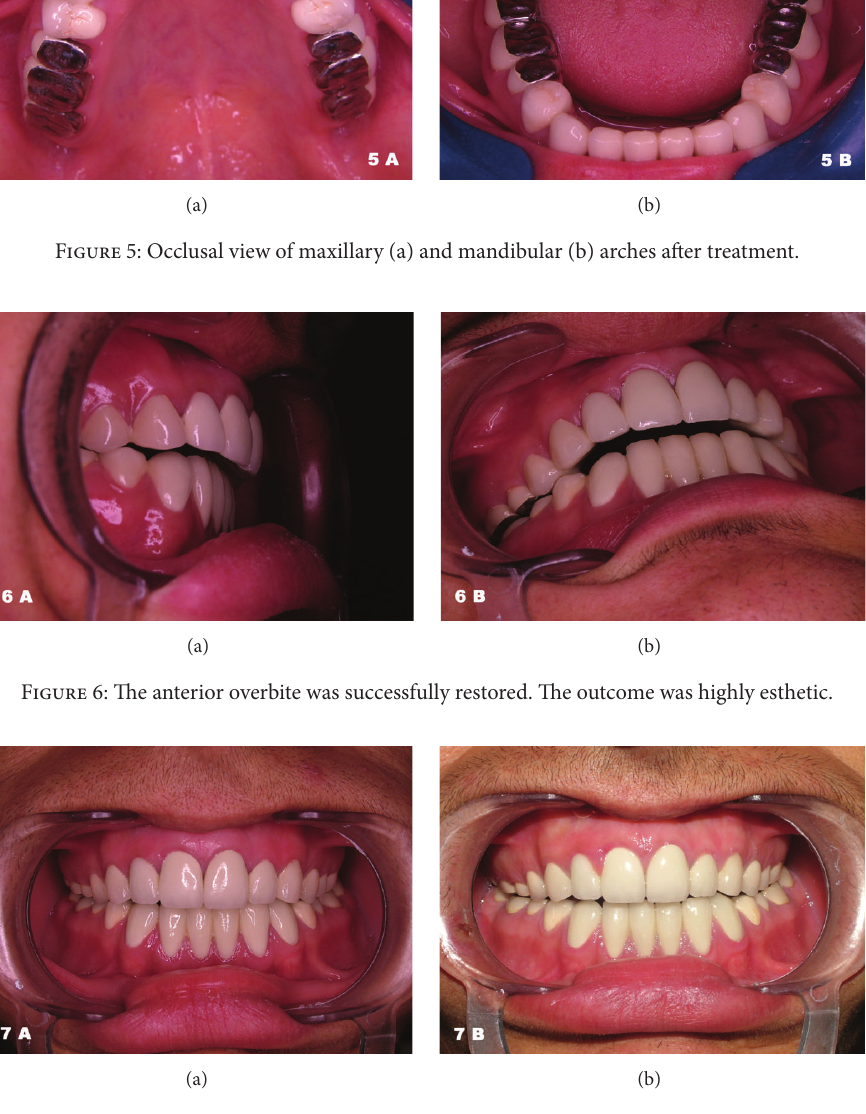
Figure 7: Intraoral frontal view of the patient right after the treatment (a) and 10 months later (b). Notice the slight gingival hyperplasia between the right maxillary central and lateral